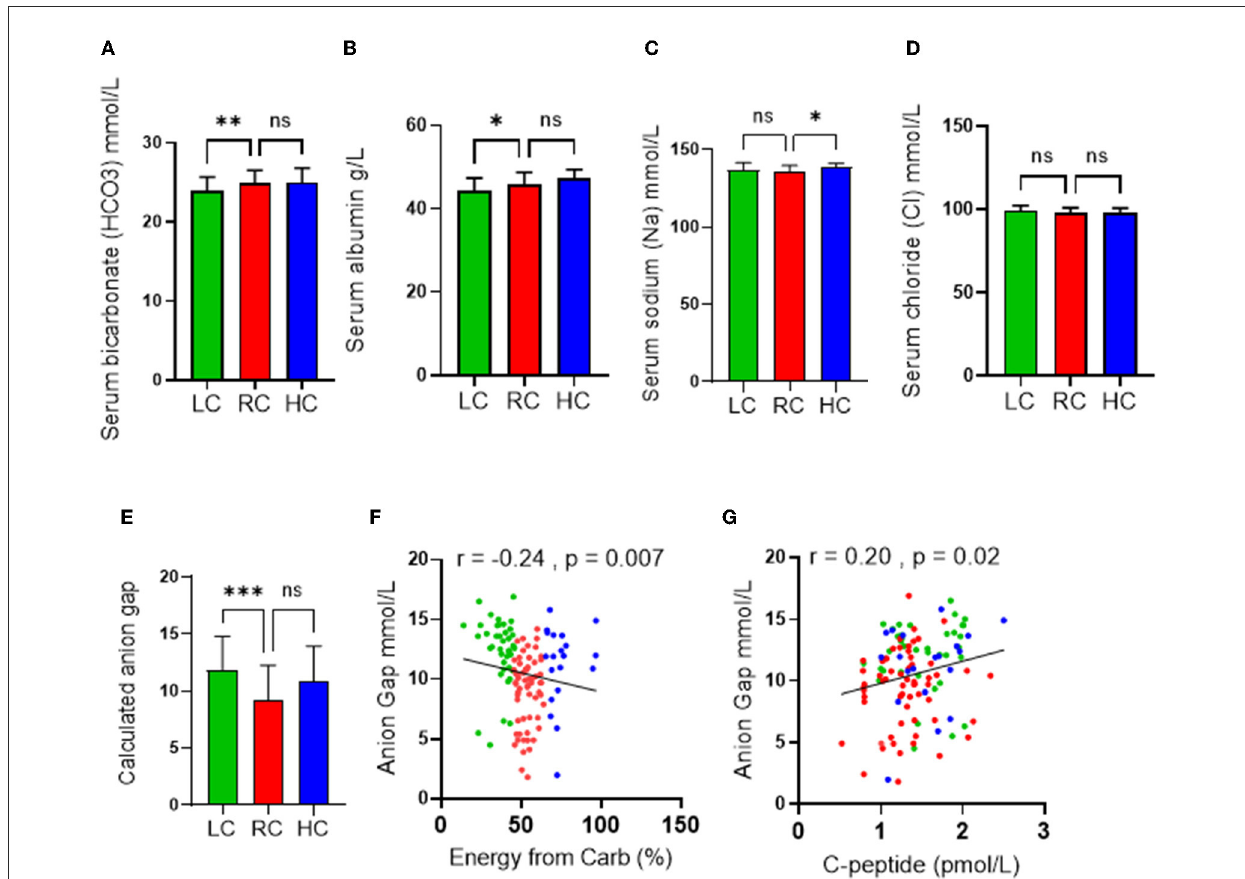
FIGURE3 Effects of the levels of carbohydrate intake on metabolic acidosis. Serum levels of (A) Bicarbonate; (B) Albumin; (C) Chloride; and (D) Sodium are shown in individuals with low-carbohydrate (LC group: < 45% of daily energy from carbohydrate), recommended range of carbohydrate (RC group: 45–65% of daily energy from carbohydrate) and high-carbohydrate (HC group: > 65% of daily energy from carbohydrate) intake. (E) Calculated anion gap is shown for individuals in LC, RC, and HC dietary groups. (F) Association (Spearman r correlation test) between anion gap and carbohydrate intake. (G) Association (Spearman r correlation test) between anion gap and C-peptide. Data are expressed as mean ± SD. ns, non-significant; * p ≤ 0.05, ** p ≤ 0.01, *** p ≤ 0.005.